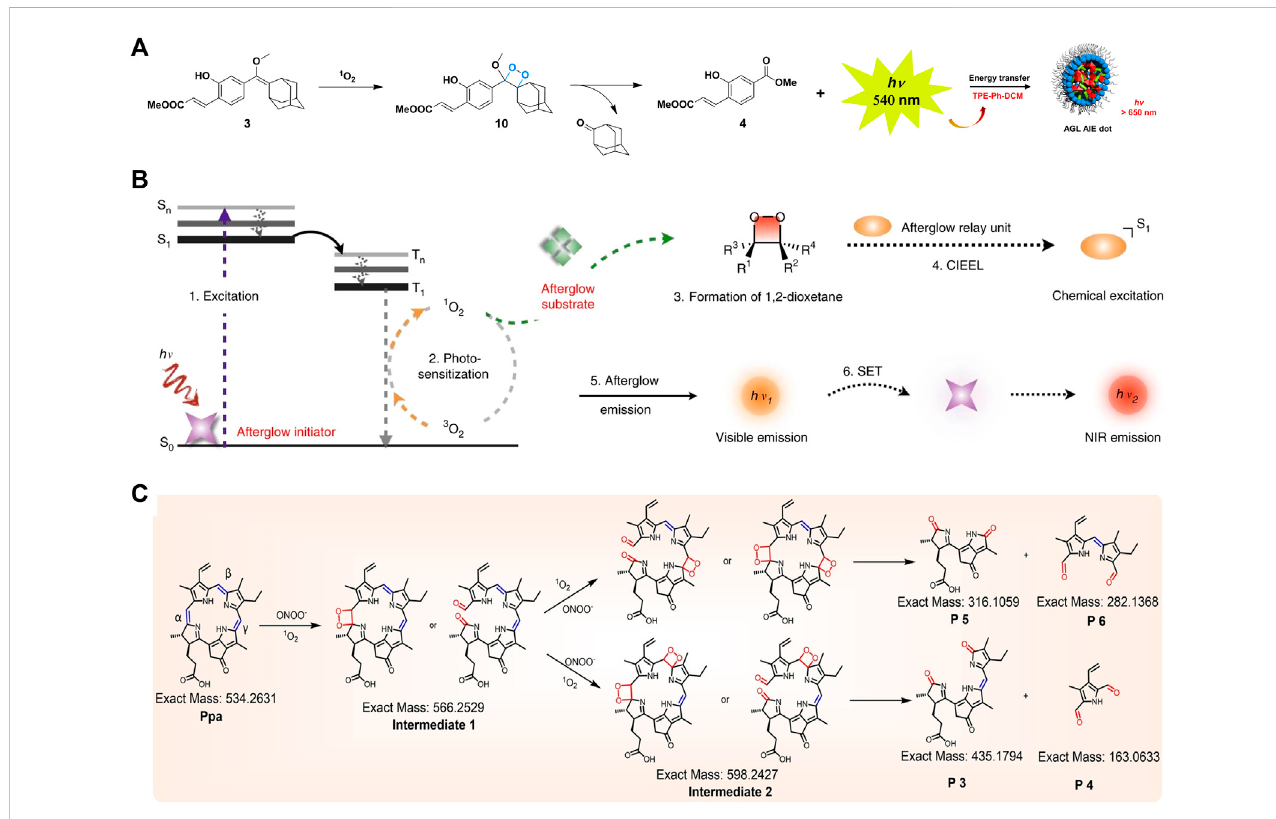
FIGURE 2 (A) Schematicdiagram of themechanism for NIR afterglowof the AGL AIE Dot (Ni etal., 2018). (B) Schematic diagram of themechanism for intraparticle afterglow luminescence of ALNPs (Jiang et al., 2019). (C) Proposed mechanism for persistent luminescence of pheophorbide A (Duan et al.,